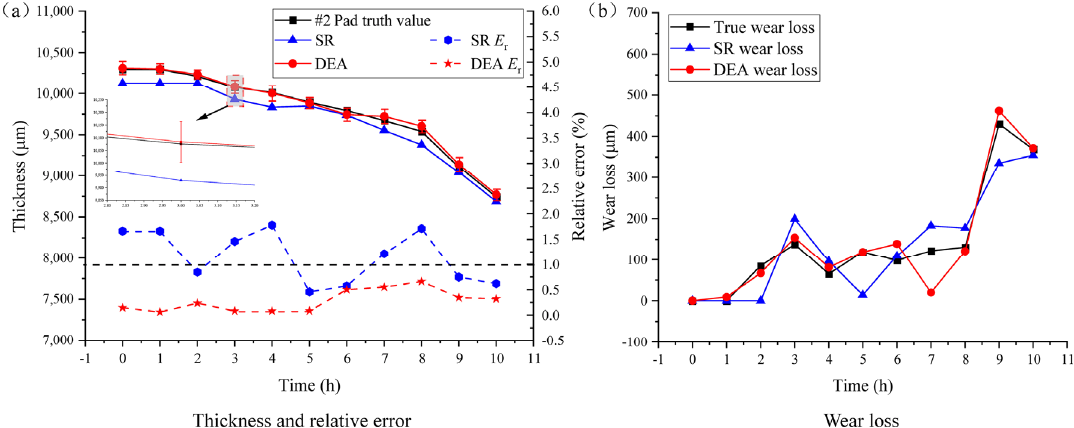
Fig. 25 Identification results of different ultrasonic methods of the #2